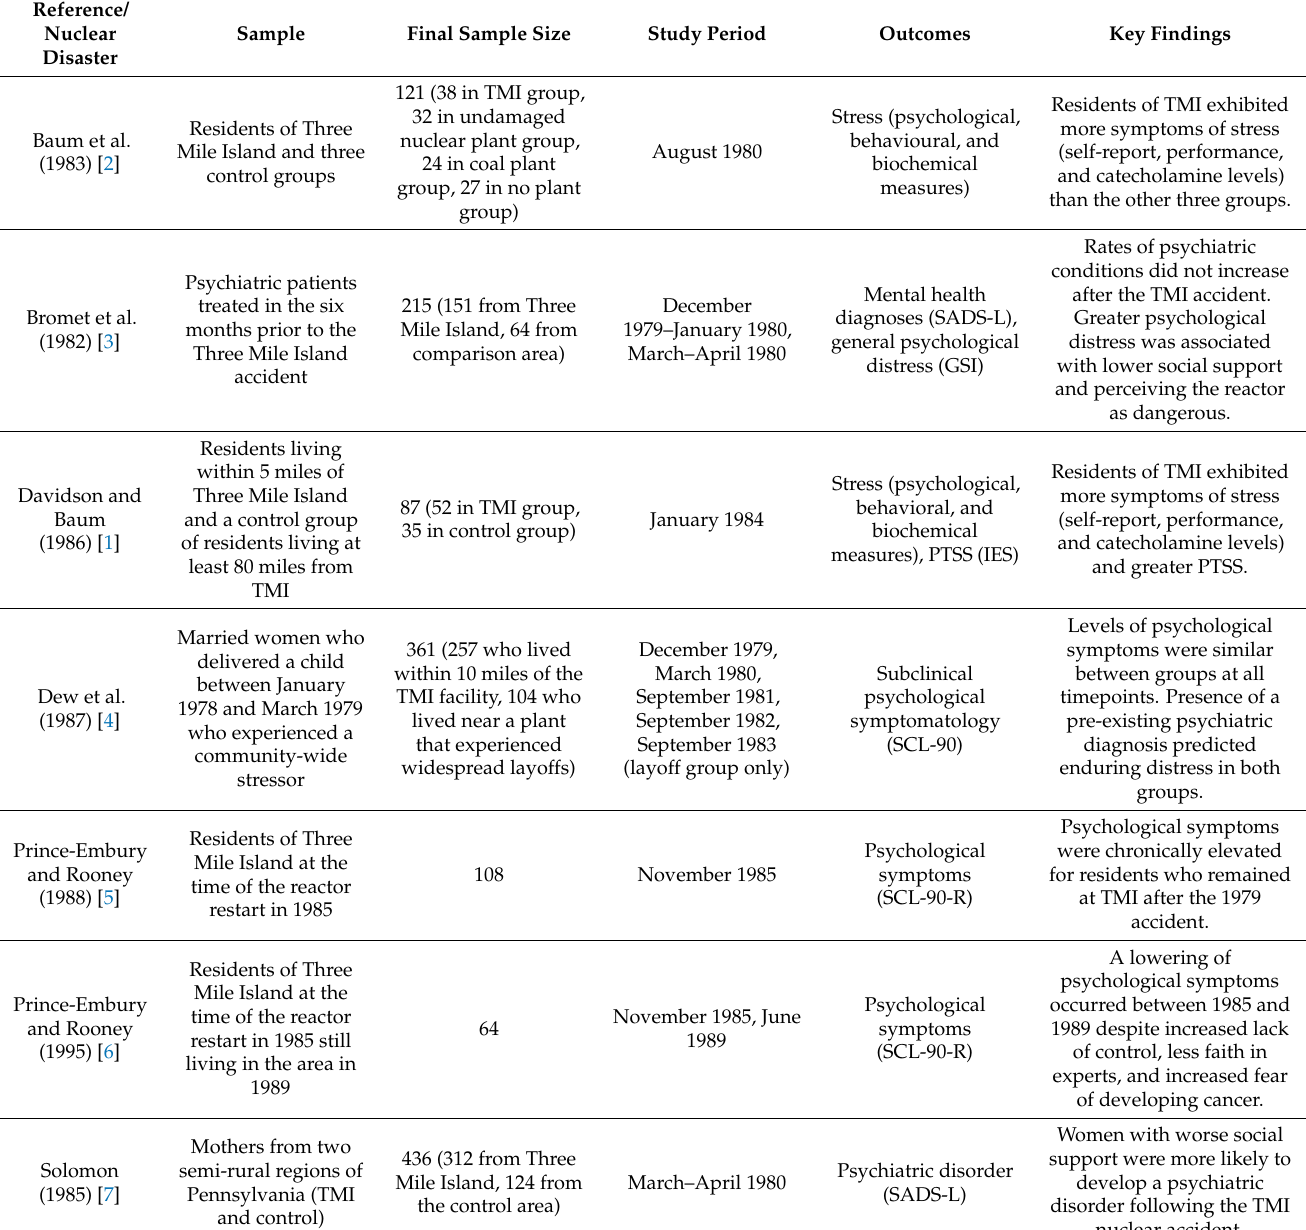
Table 1. Studies assessing psychological consequences of the Three Mile Island nuclear